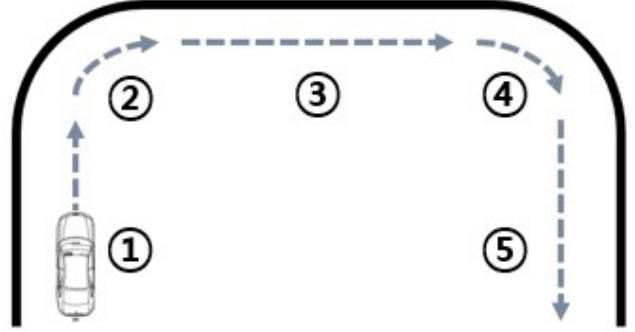
Figure 6. Proposed virtual road condition (turning right). Table 1. Proposed driving conditions and the measured distance between a driver’s hand and the three infrared sensors of the center console for each route in the virtual road condition. (s: seconds) Route